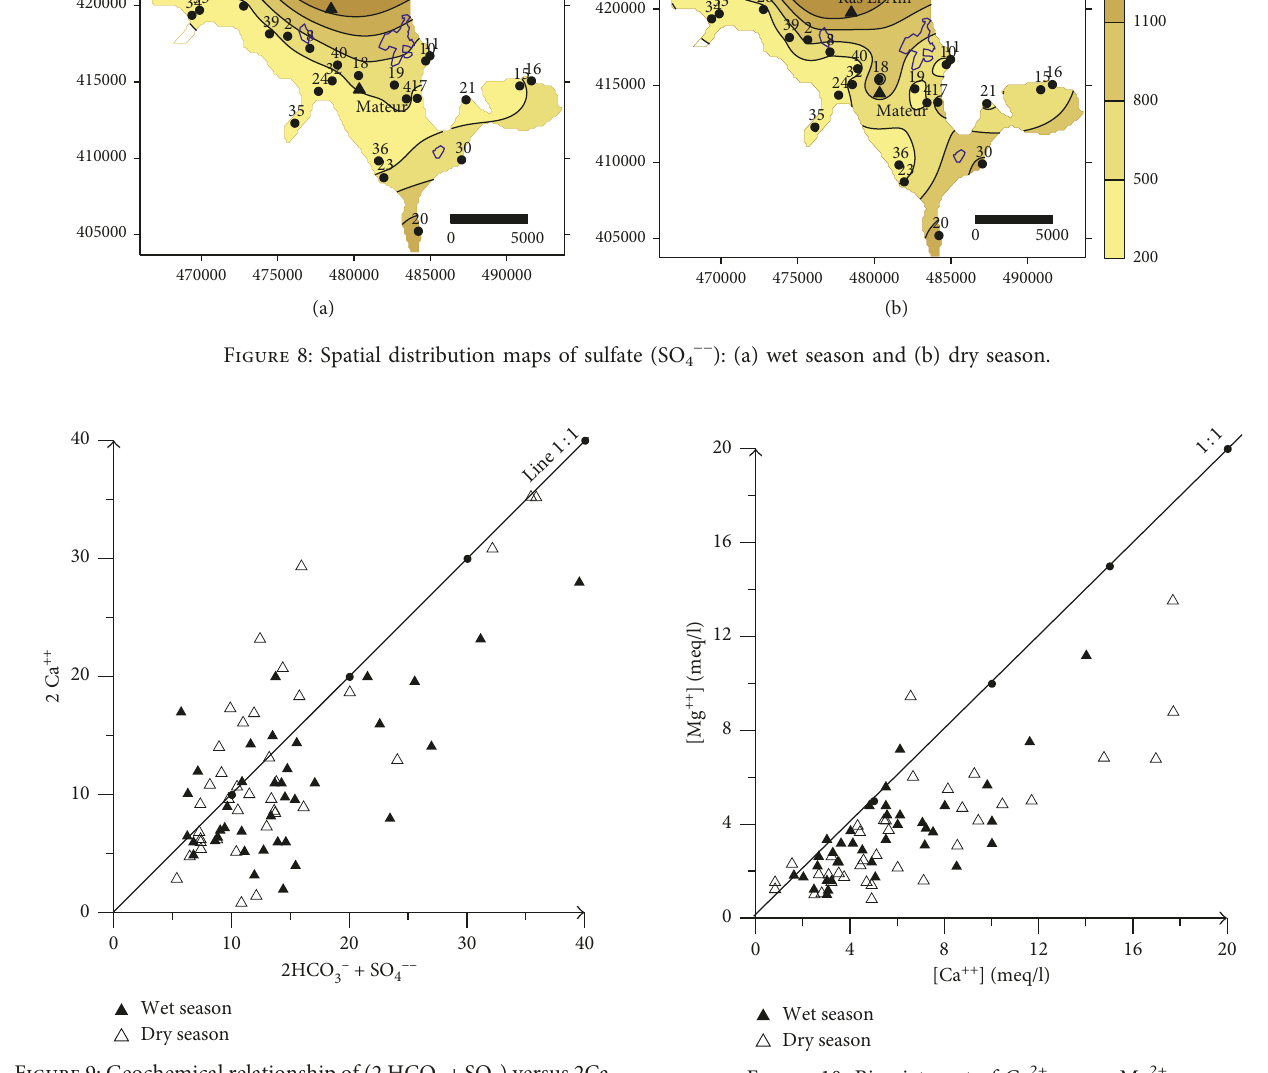
Figure 9: Geochemical relationship of (2 HCO 3 +SO 4 ) versus 2Ca. Figure 10: Bivariate pot of Ca 2+ versus Mg 2+